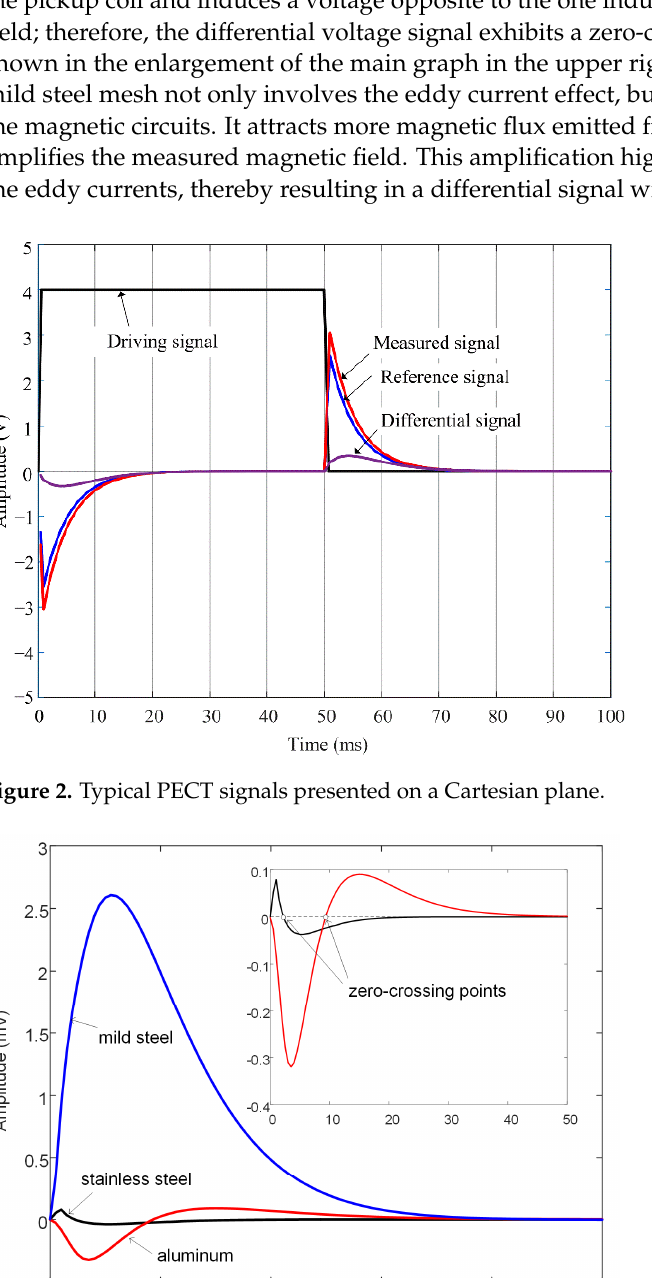
Figure 2. Typical PECT signals presented on a Cartesian plane.